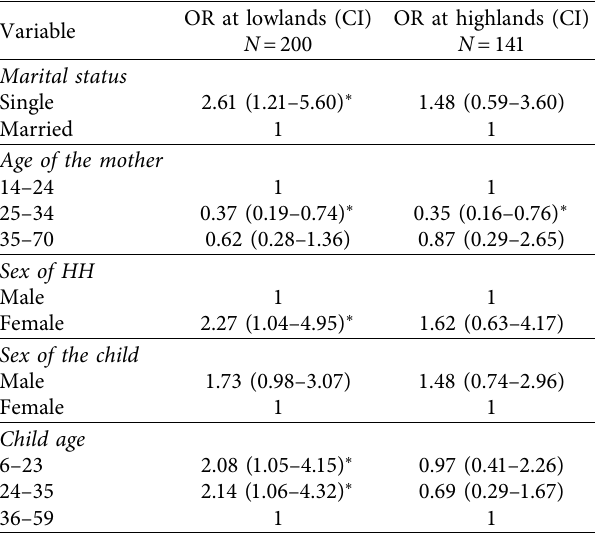
Table 6: Determinants of stunting in lowlands and